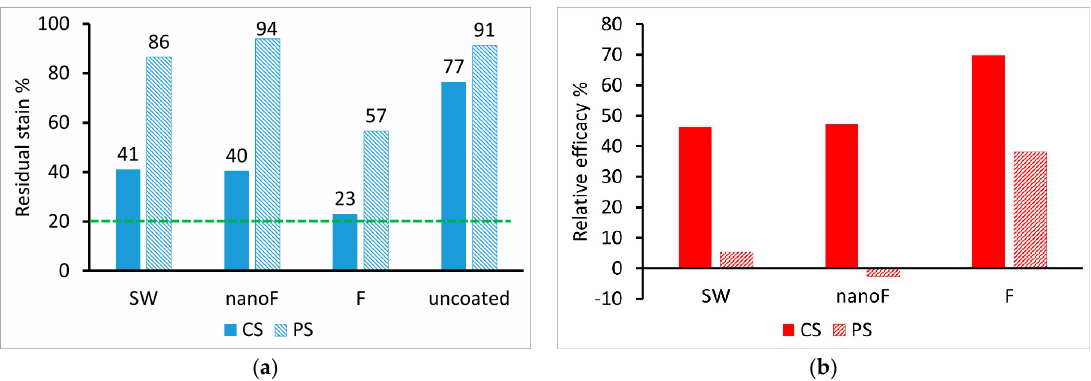
Figure 12. Evaluation of the felt-tip marker removal: ( a ) residual stain, as defined in Equation (2), with the green line indicating the acceptable threshold; ( b ) relative efficacy, as defined in Equation (3).